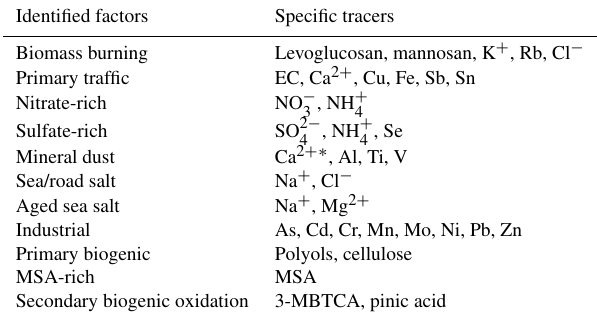
Table 2. Summary of PMF-resolved sources and their specific trac-